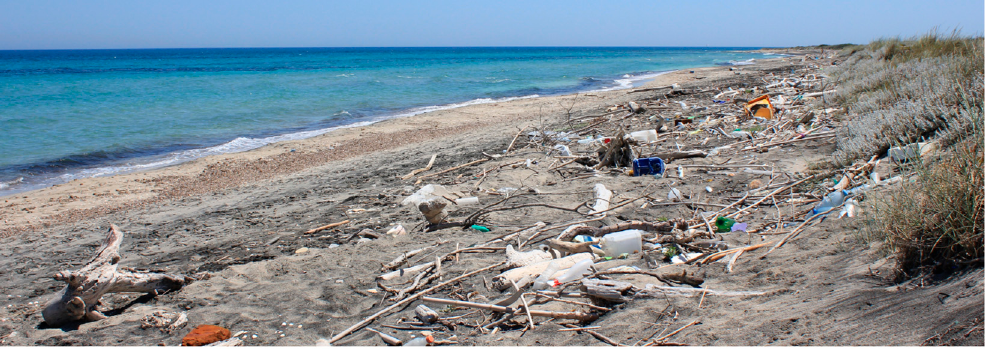
Figure 4. Continuous accumulations of beach litter at Cesine Natural Reserve, Lecce Province.